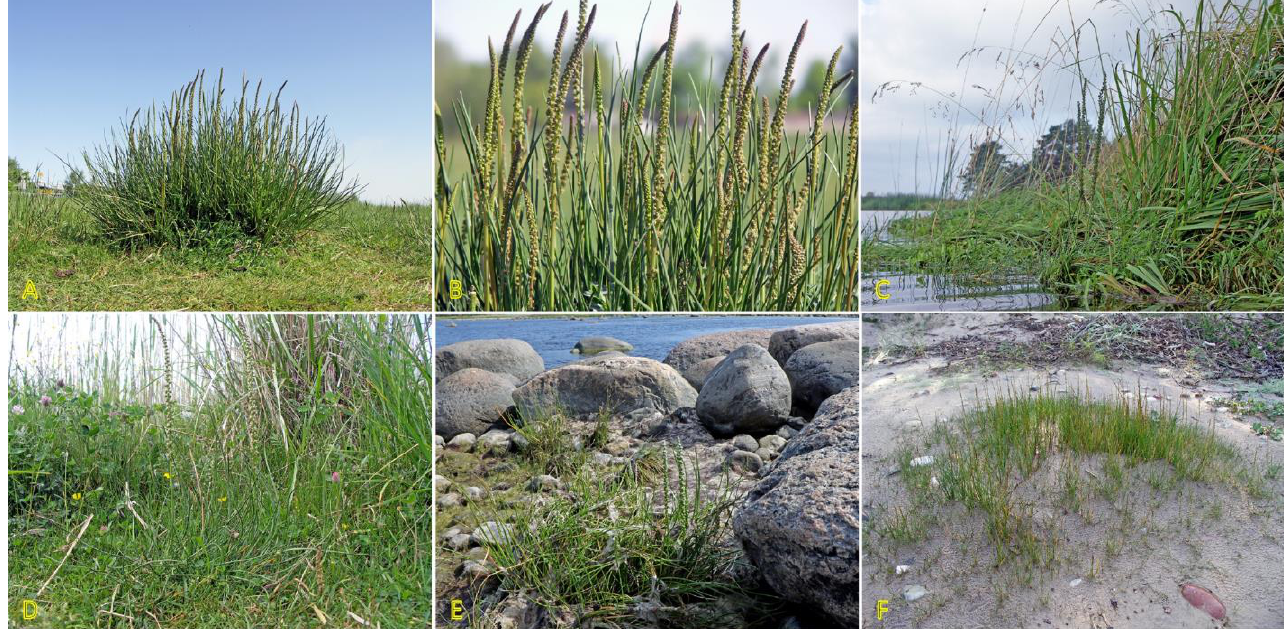
Figure 6. Triglochin maritima plants on a salt- affected meadow in Liepāja, Latvia ( A ), detail of inflorescences ( B ), on saline shores of river Buļļupe, Rīga, Latvia ( C ), on a coastal meadow in Mērsrags, Latvia ( D ), on a stony beach in Matsi-Sömeri, Estonia ( E ). Triglochin palustris on a spring-affected wet beach in Liepene, Latvia ( F ).